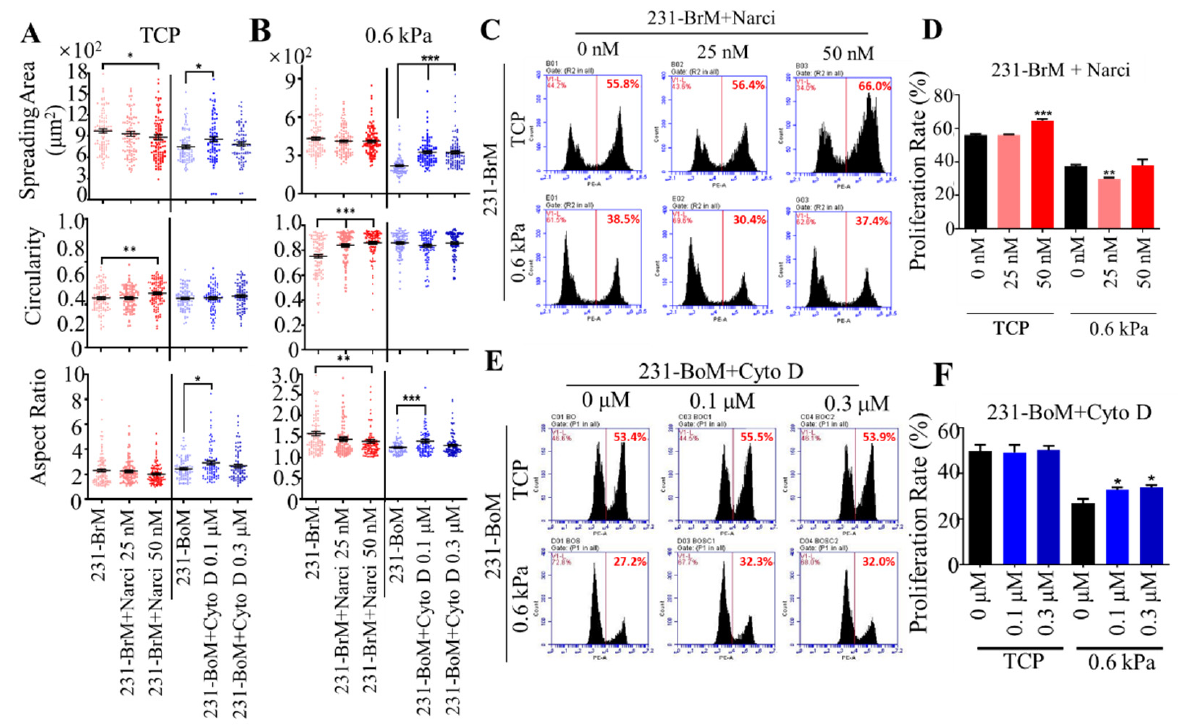
Figure 3. Stabilizing/disrupting the cytoskeleton of breast cancer cells with bone/brain tropism influences cell morphology and proliferation on soft substrates. ( A , B ) The influence of stabilizing and disrupting the cytoskeleton on the morphology of 231-BrM and 231-BoM cells. While 231-BrM cells were treated with Narci (25 nM, 50 nM), 231-BoM cells were treated with Cyto D (0.1 µ M, 0.3 µ M). Cell spreading area, circularity, and aspect ratio were then measured on TCP ( A ) and 0.6 kPa substrates ( B ). n > 100 cells/condition; 3 independent experiments. ( C , D ) Stabilizing the cytoskeleton of 231-BrM cells suppresses their proliferation on soft but not stiff substrates. In addition, 231-BrM cells were treated with 25 or 50 nM Narci and then cultured on TCP and 0.6 kPa substrates for 24 h, respectively. Then, cell proliferation was measured by EdU proliferation assay. n = 3. ( E , F ) Disrupting the cytoskeleton of 231-BoM cells enhances cell proliferation on soft but not stiff substrates. In addition, 231-BoM cells were treated with 0.1 or 0.3 µ M Cyto D and then cultured on TCP and 0.6 kPa substrates for 24 h, respectively. n = 3. The data represent mean ± SEM. * p < 0.05; ** p < 0.01; and *** p < 0.001.